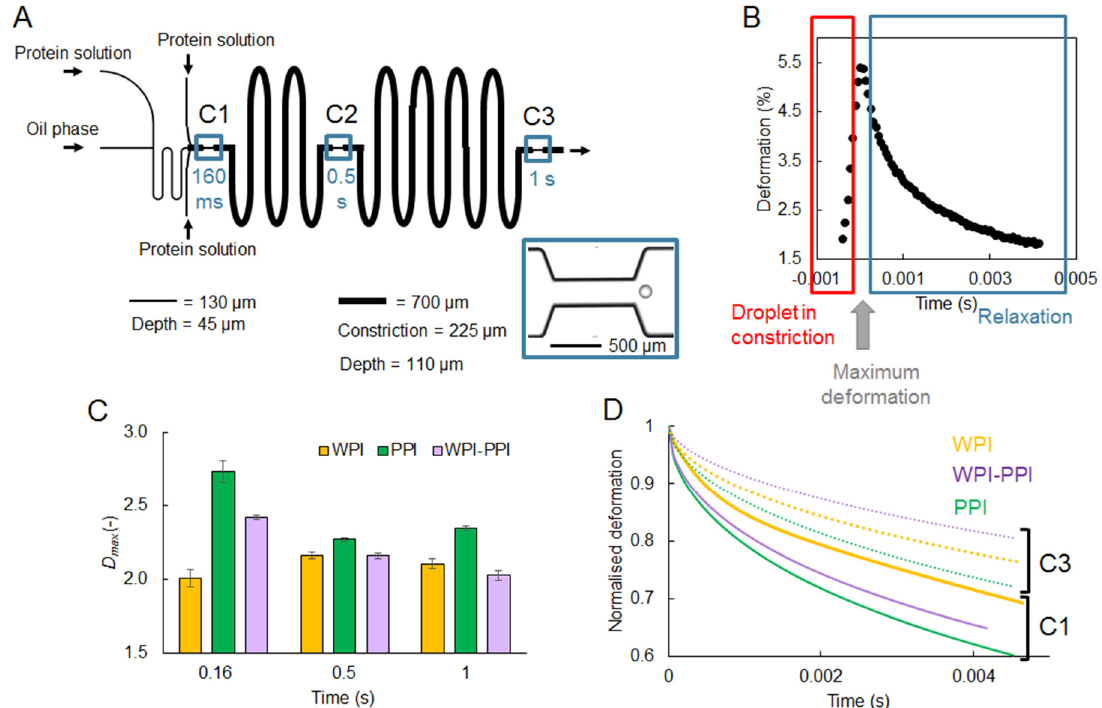
Figure 9. ( A ) Layout of the microfluidic rheology chip. The T-junction where droplets are formed (on the left) is the same as in the coalescence chip (Figure 7). The three constrictions (C1, C2, and C3) have a 70° angle. ( B ) Typical deformation pattern in time recorded by image analysis through passage of an emulsion droplet in a constriction. ( C ) Examples of maximum droplet deformations measured for droplets stabilized by different proteins (WPI, whey protein isolate; PPI, pea protein isolate; WPI-PPI, blend of both in 1:1 mass ratio), at the different constrictions C1, C2, and C3. ( D ) Examples of normalized relaxation curves for droplets stabilized by the same proteins, at constriction C1 (solid lines) or C3 (dotted lines). Reproduced from [89], under the CC BY license 4.0.